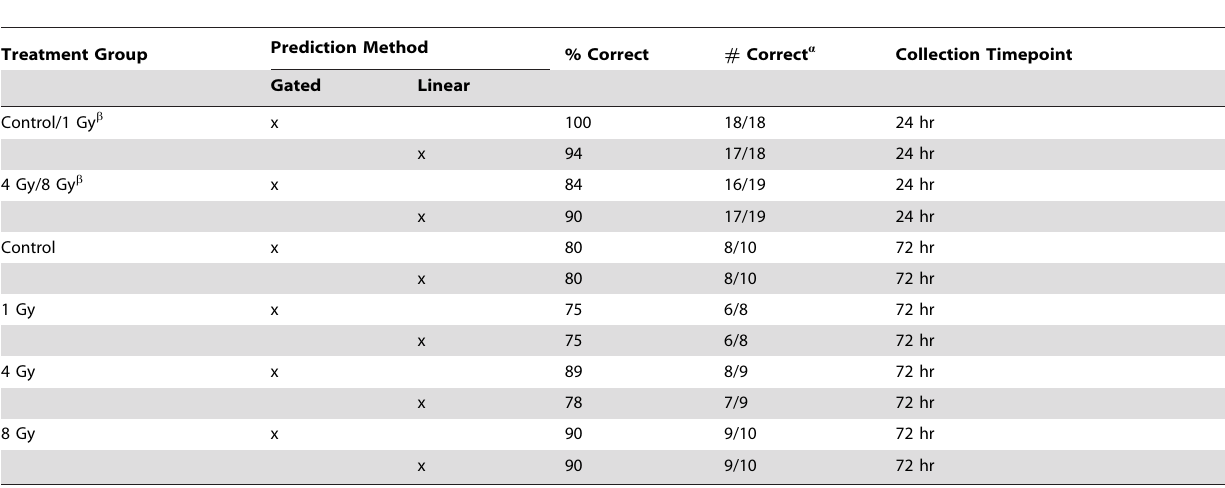
Table 1. Results of Blinded Dose Prediction Analysis Using Plasma FL at 24 hrs and 72 hrs following Total Body Irradiation.